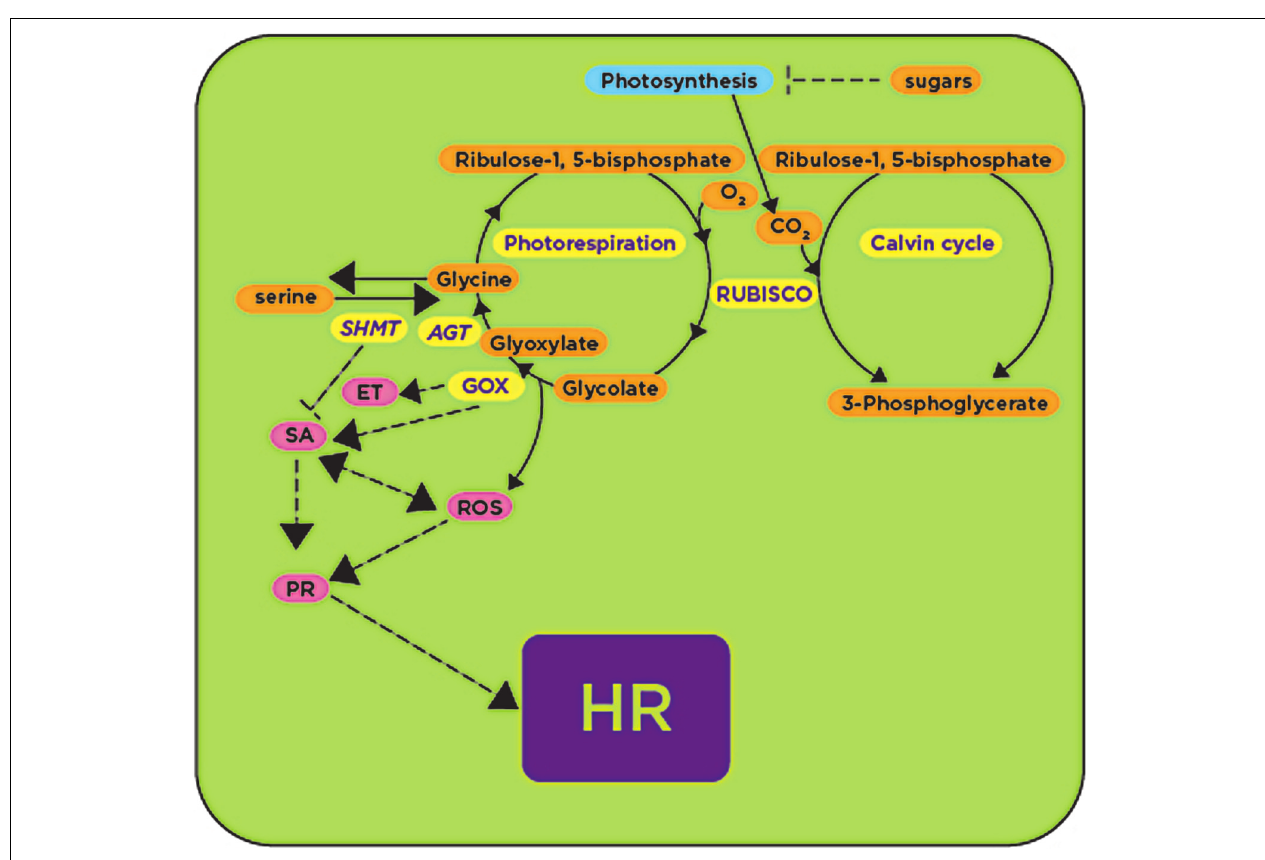
(shown in pink) leading to the HR, while SHMT activity antagonizes GOX, repressing (blunt-ended lines) downstream defense responses. GOX, glycolate oxidase; SHMT, serine hydroxymethyltransferase; AGT, alanine glyoxylate transaminase; ET, ethylene; SA, salicylic acid; HR, hypersensitive response. Processes or genes found to be upregulated in the presence of avirulent pathogens or pathogen-derived elicitors are shown in